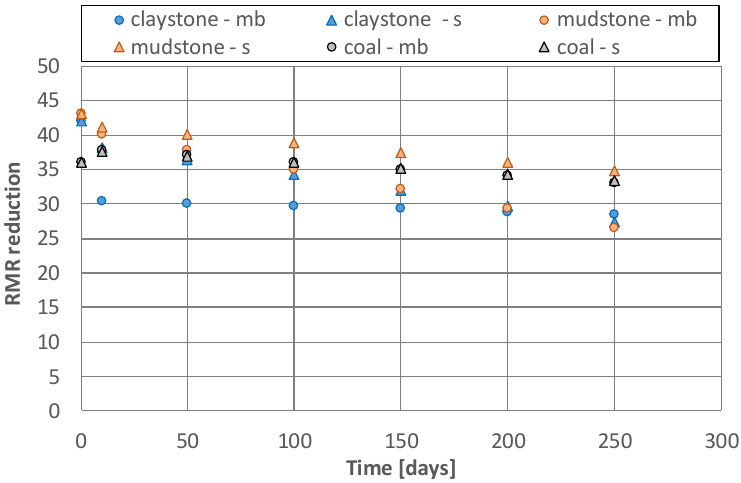
Figure 19. RMR decrease corresponding to m b and s decrease versus time—rocks around roadway F-33.